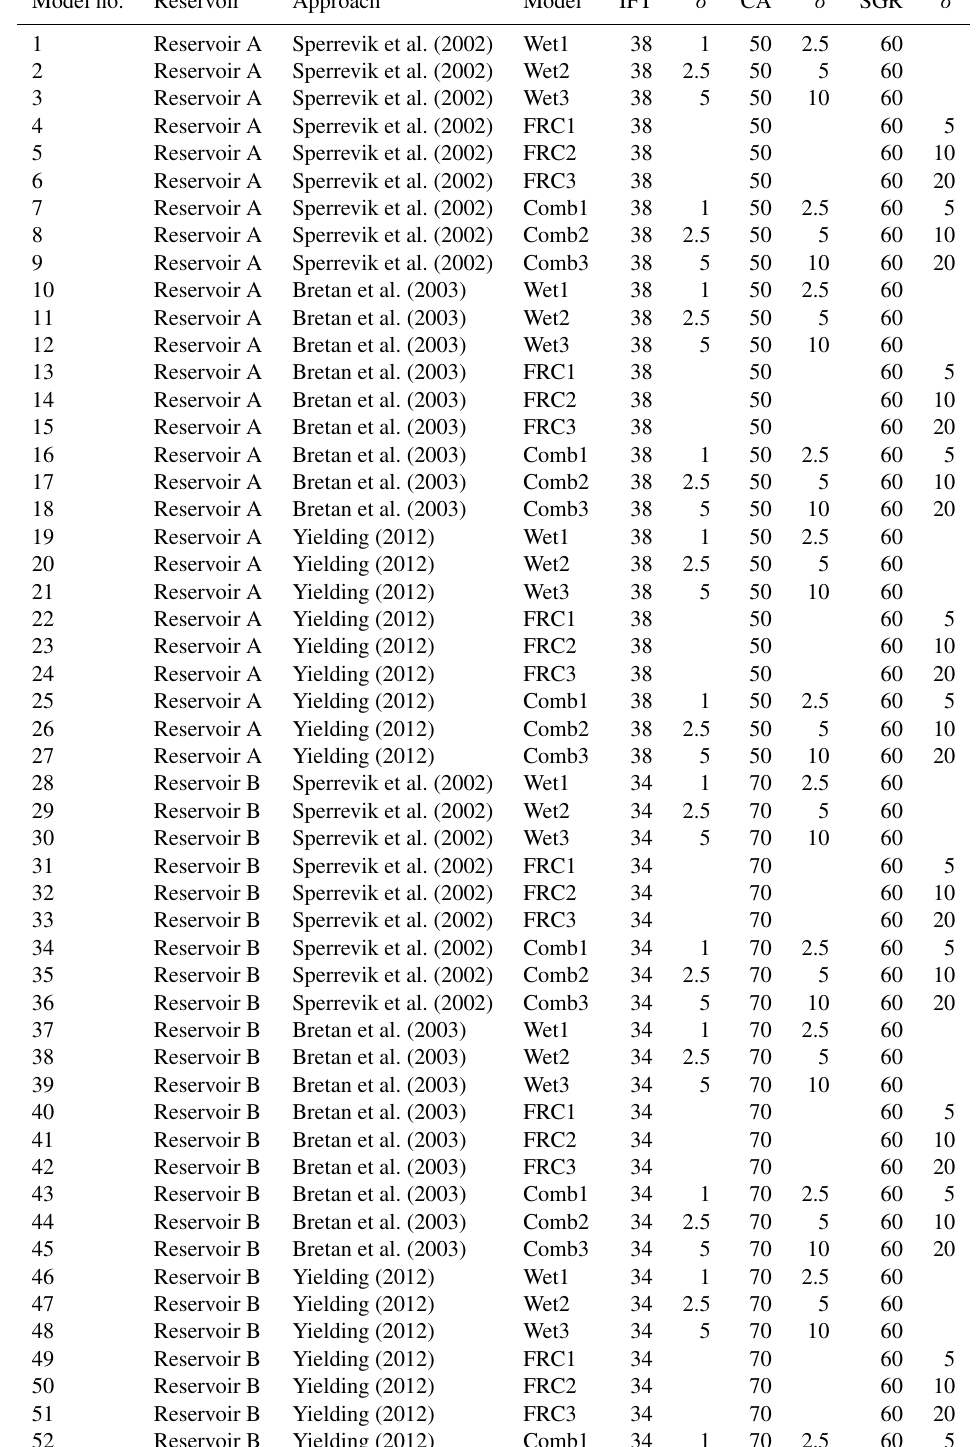
Table 1. Table listing the input parameters for the MCMO modelling. Reservoir A and B refer to the two theoretical reservoirs described in the text, the approach refers to the algorithm used (see text), and the model indicates whether uncertainties in wettability parameters (Wet), fault rock composition (FRC), and/or combined uncertainties (Comb) are modelled. IFT is the interfacial tension (mNm − 1 ), CA the contact angle, SGR the shale gouge ratio as a parameter for fault rock composition, and PTS the pore-throat size in nanometres; σ is the standard deviation and describes the shape of the input normal distribution. Model